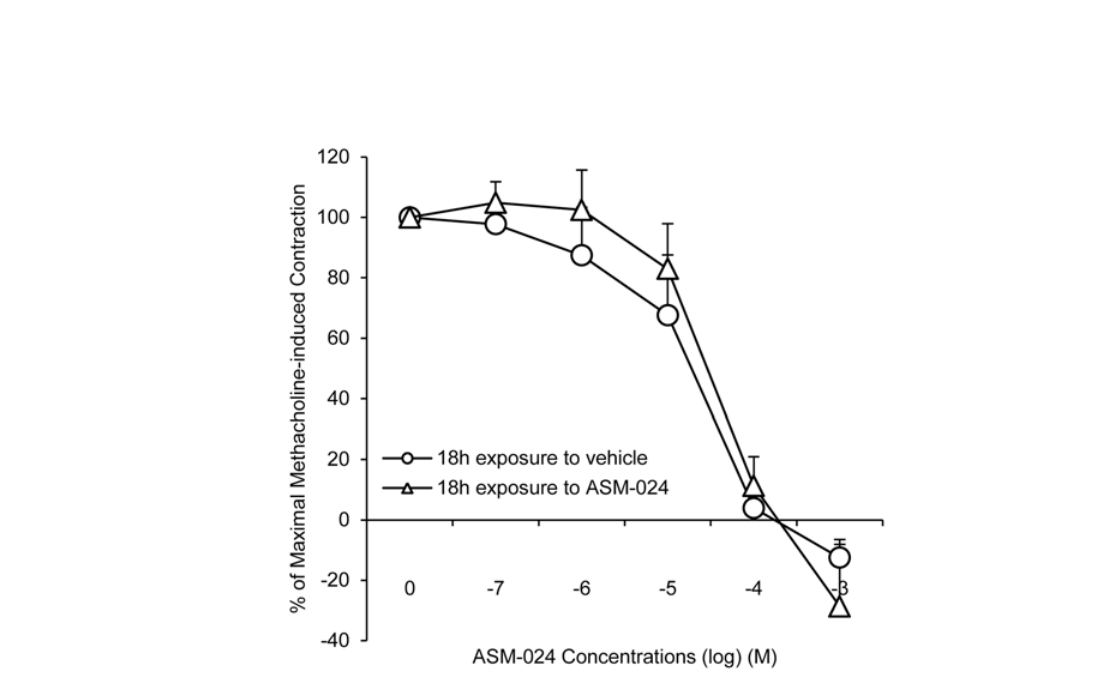
PLOS ONE | DOI:10.1371/journal.pone.0120095 March 23,